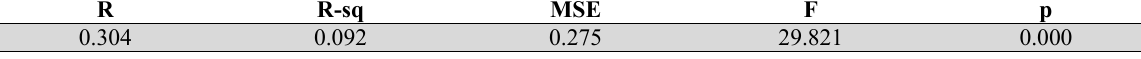
Model Summary for effect of job satisfaction on job performance when organizational commitment is controlled R R-sq MSE F p